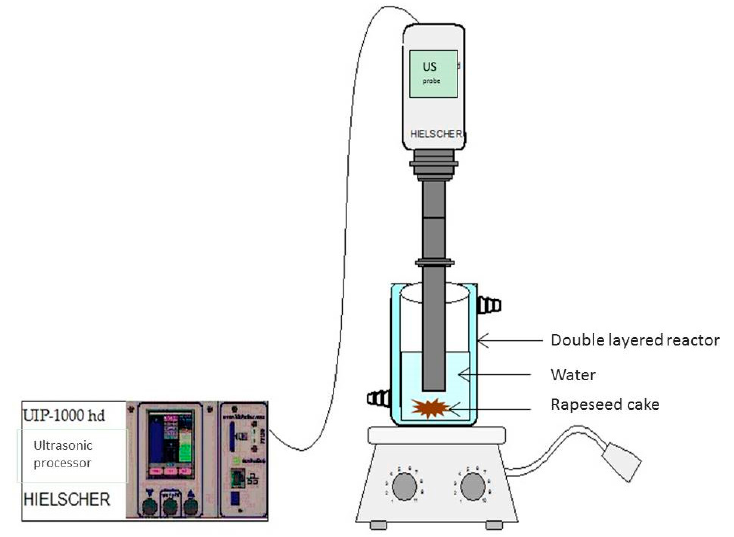
Figure 9. Ultrasound-Assisted Extraction of proteins from rapeseed cake.